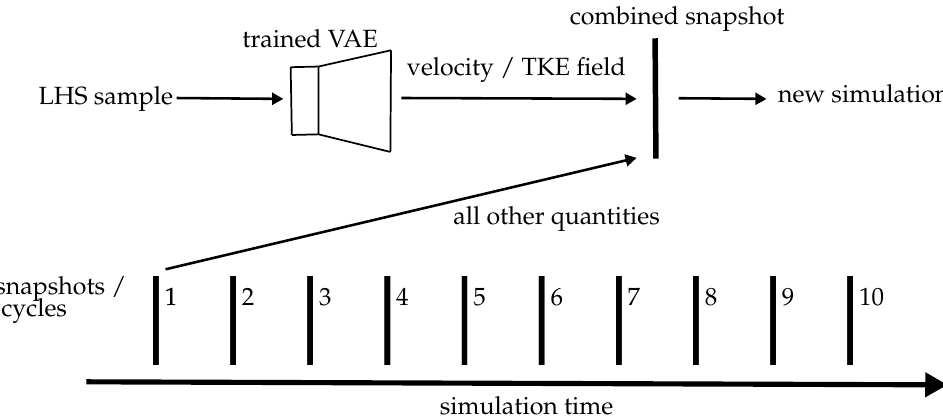
Figure 5. Generation of artificial velocity and TKE field using the trained VAE. The corresponding initial field is created by the new fields and the residual fields of cycle